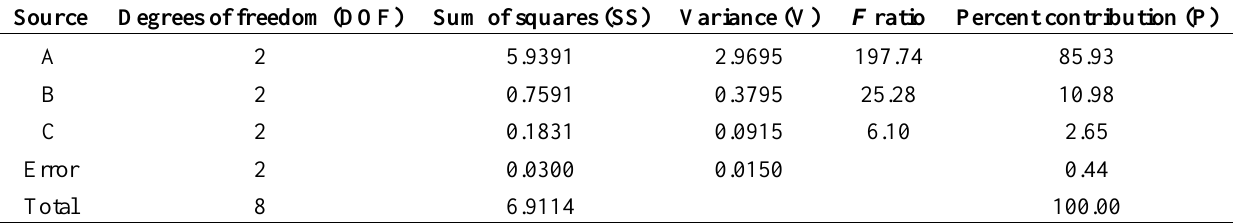
Table 4. Variance (ANOVA) Table for ultimate tensile strength (UTS).